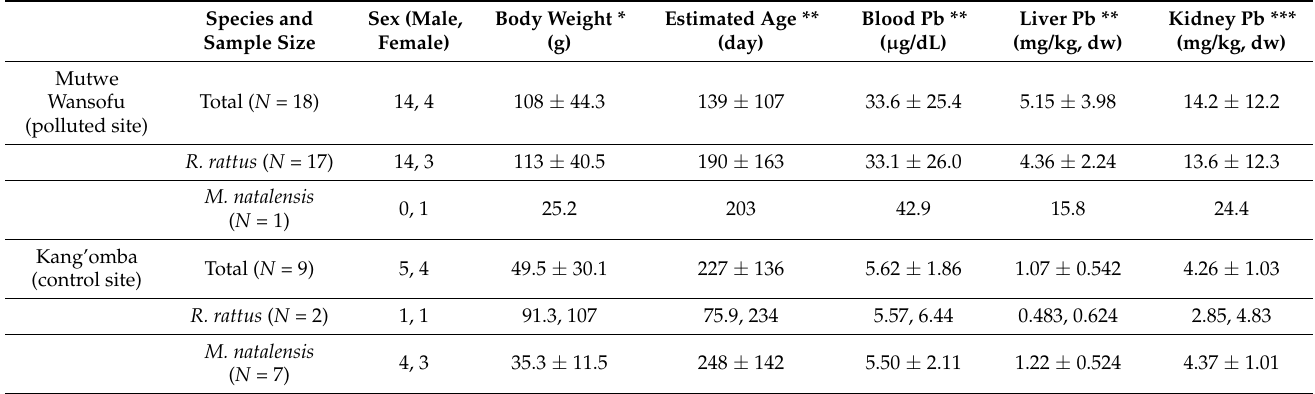
Table 1. Identified species, characteristics, and tissue Pb levels of the target animals.